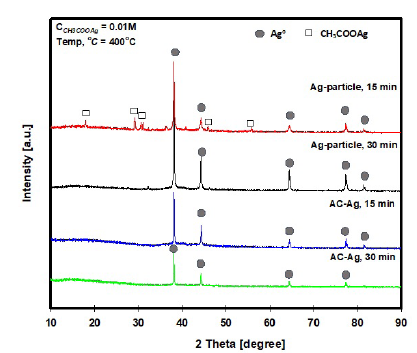
Fig. 2. XRD patterns of the AgNPs and AC-Ag at the reaction time of 15 and 30 min